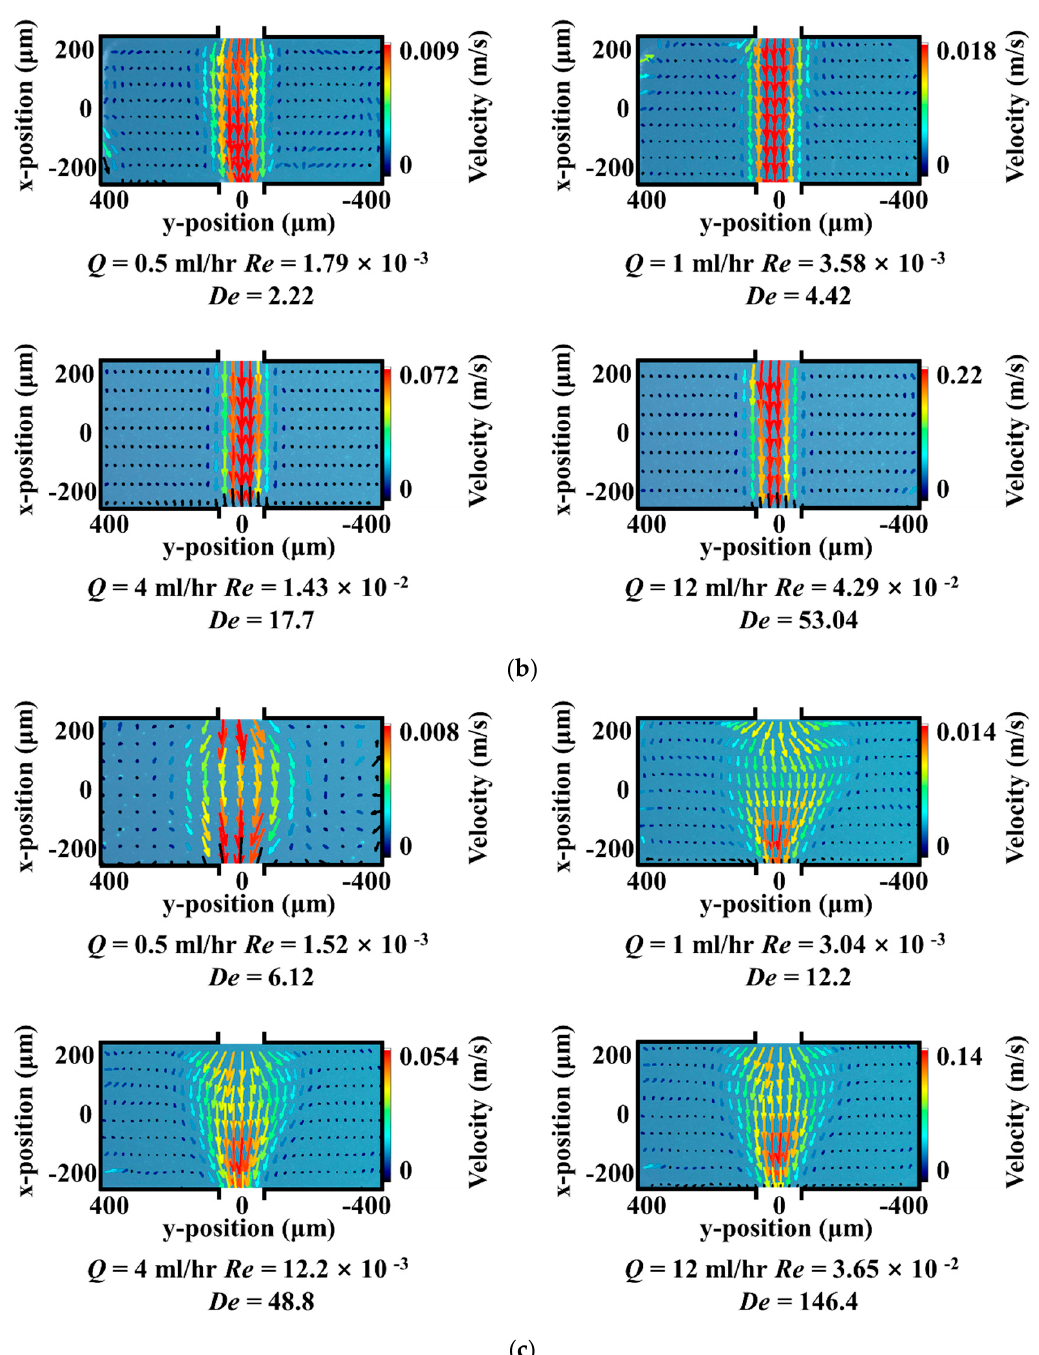
Figure 5. The development of flow patterns for the flow of ( a ) Newtonian fluid, ( b ) HPAM solution and ( c ) VES fluid in short pore-throat structure, flow rates range from 0.5 mL/h to12 mL/h.